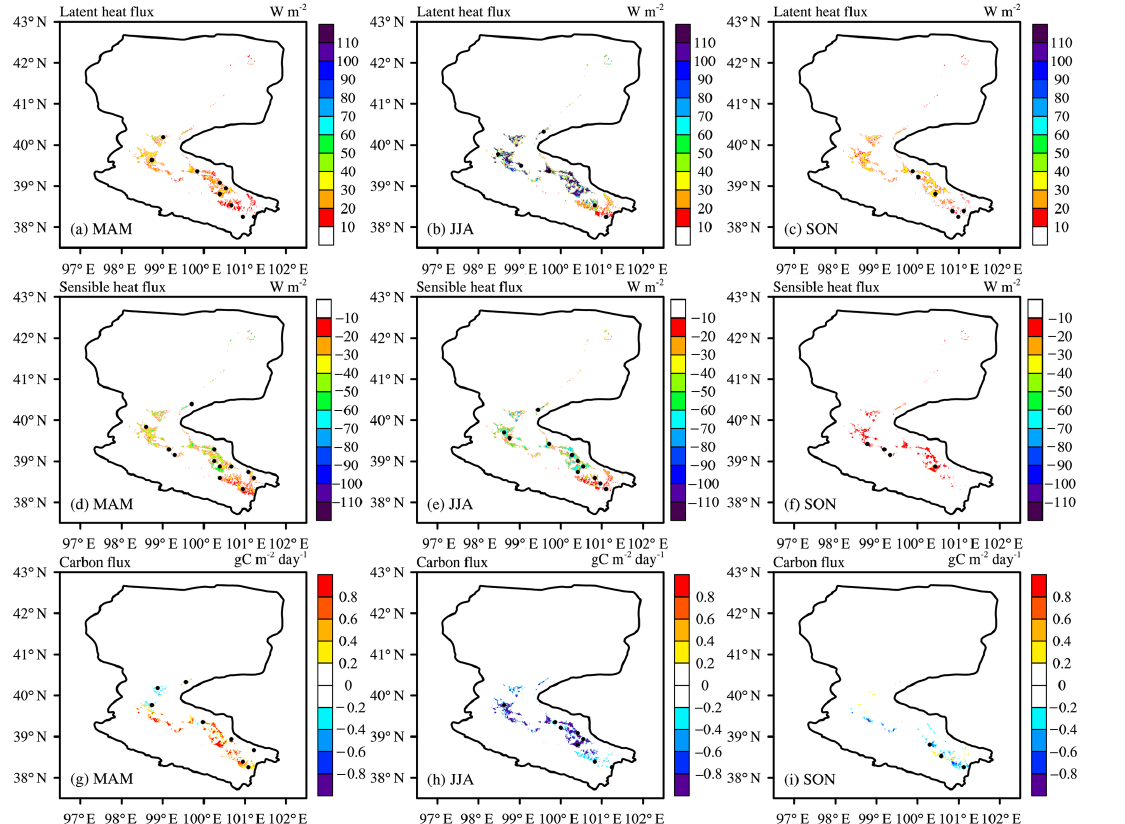
Figure 8. Climatic spatial pattern of (a–c) latent heat flux, (d–f) sensible heat flux, and (g–i) carbon flux differences between IRR and CTL in (a, d, g) spring, (b, e, h) summer, and (c, f, i) autumn, averaged from 1981 to 2013. The dots represent the area that passed the Student’s t test at a 95% confidence